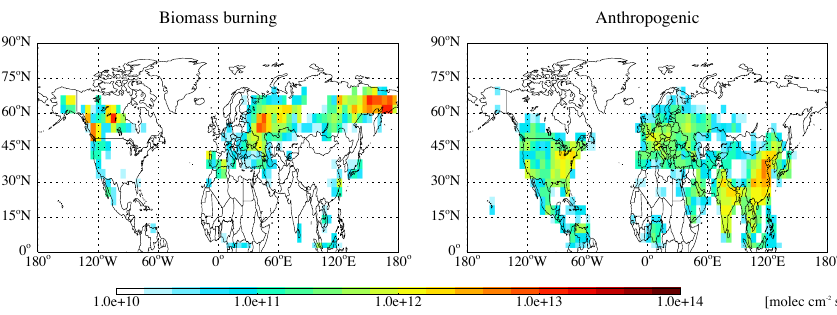
Fig. 10. Mean Northern Hemisphere CO emissions from biomass burning and anthropogenic sources (moleculescm − 2 s − 1 ) averaged over 12 July to 4 August 2010. Biomass burning emissions are from the FLAMBE inventory (Reid et al., 2009). Anthropogenic emissions in the model are as those described in Sect.